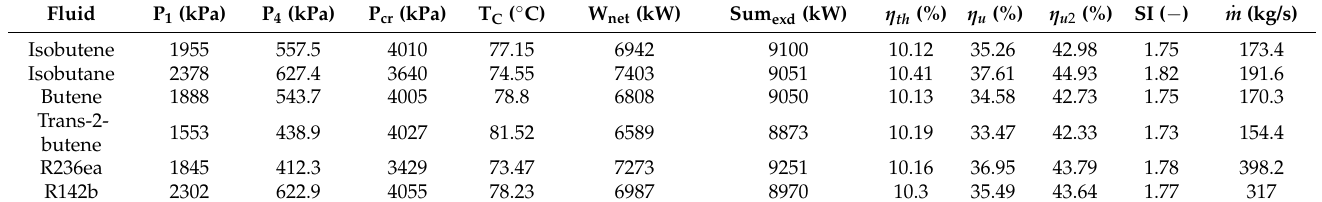
Table 2. Optimized model for different working fluids for 5 ◦ C pinch point for the simple ORC model. Fluid